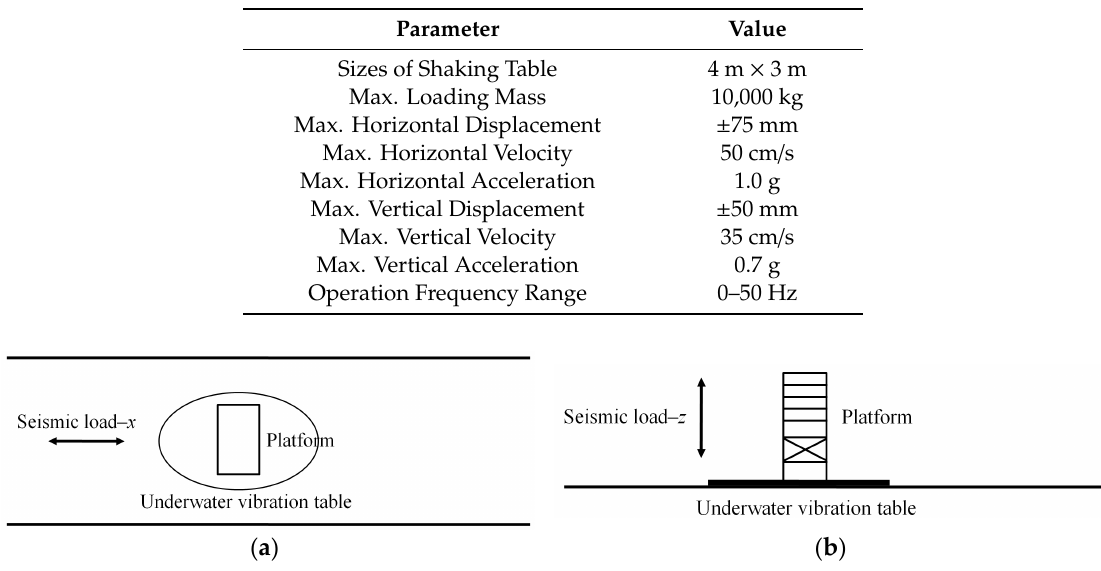
Table 4. Parameters of the earthquake simulating system.